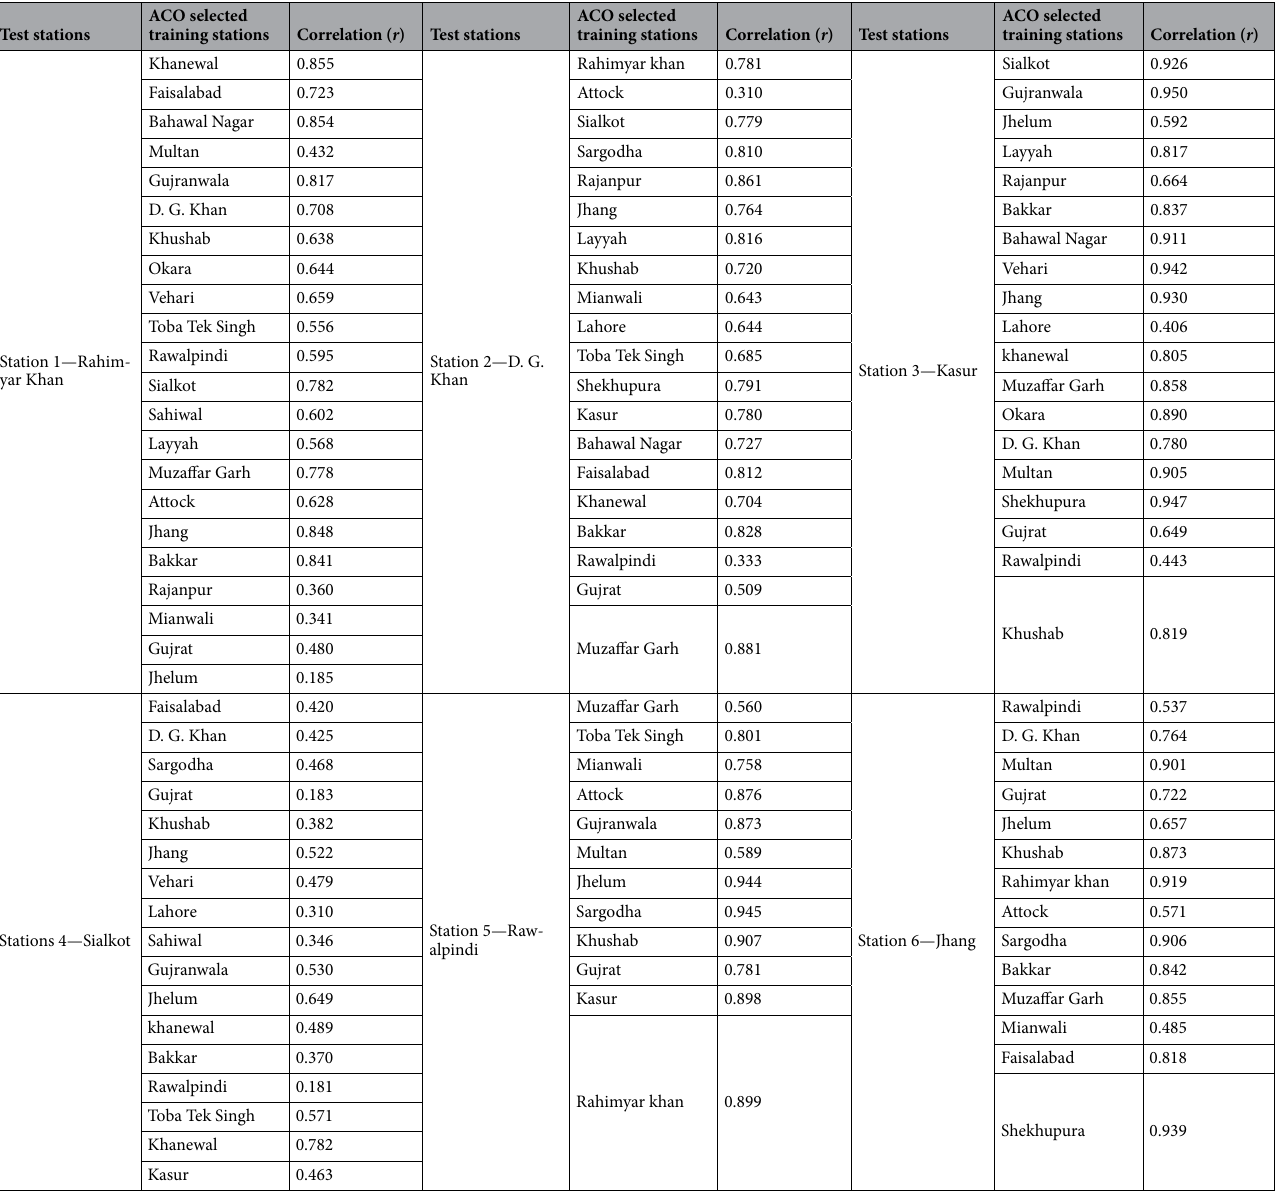
Table 2. Selected training stations using ant colony optimization (ACO) algorithm with the correlation coefficient ( r ) for each training station against the testing station.